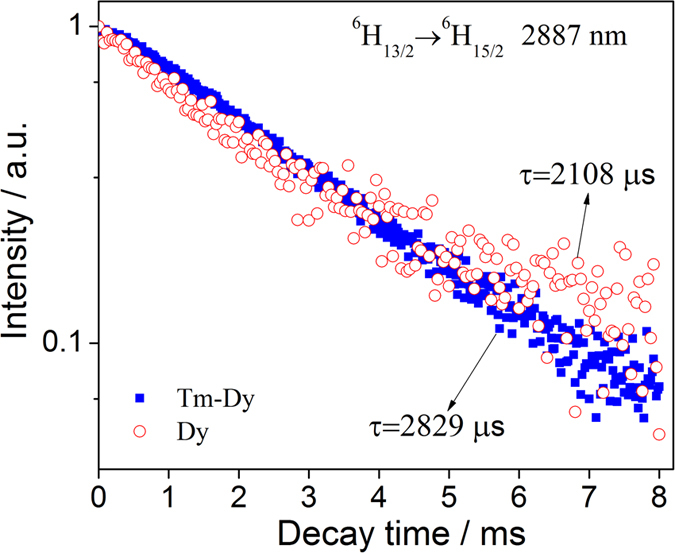
Decay curves of 6H13/2 → 6H15/2 transition (2887 nm) in Dy3+-doped and Tm3+-Dy3+co-doped 65GeS2–25In2S3–10CsI glasses.